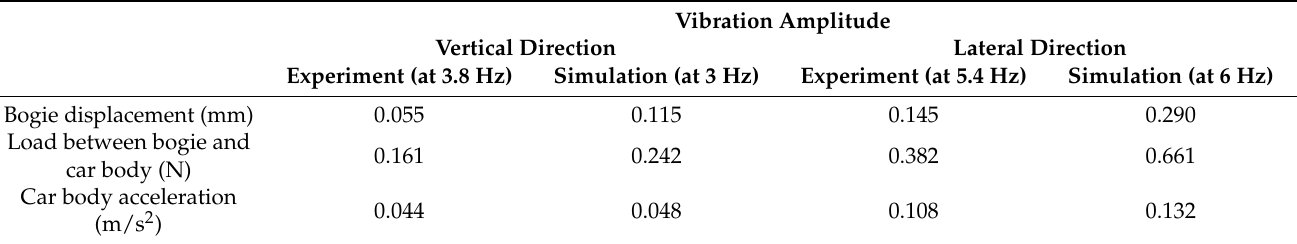
Figure 9. Dynamic characteristics in the frequency domain: ( a ) vertical direction, ( b ) lateral direction. Table 4. Comparison of experiment and simulation based on the fast Fourier transform results.